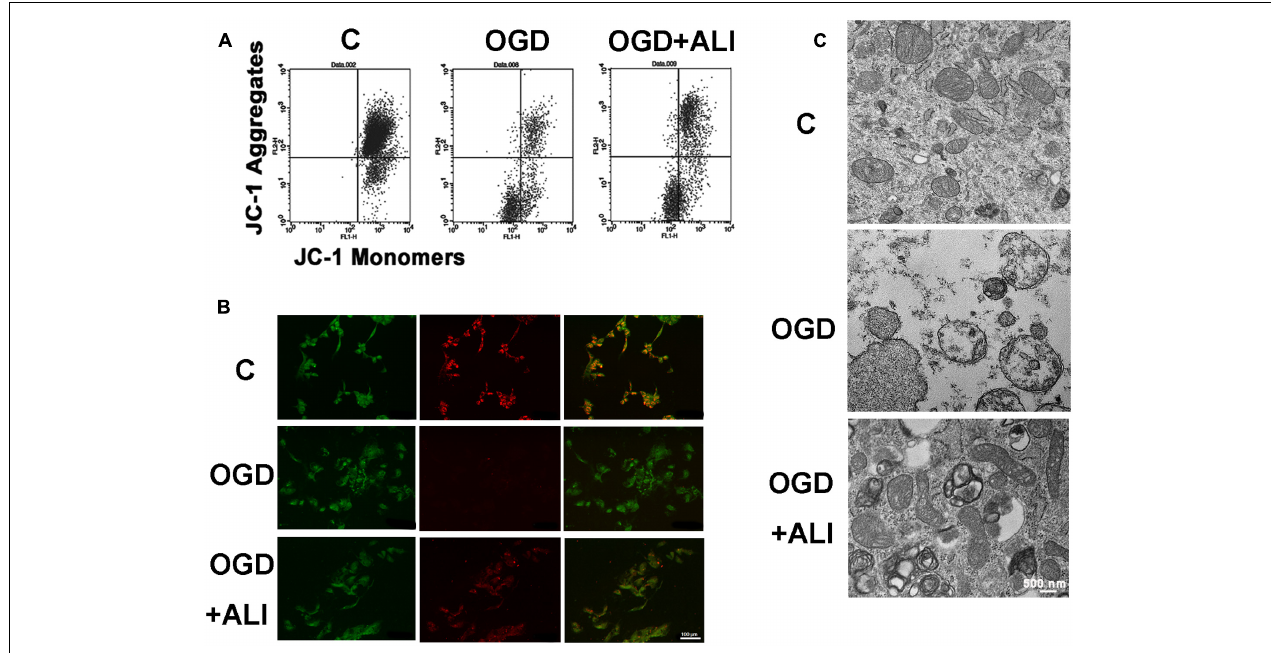
FIGURE 5 | Aliskiren attenuates OGD-induced the reduction of mitochondrial transmembrane potential (MTP) and recovers mitochondrial intact in H9c2 cells. (A) Flow cytometric analysis of MTP by JC-1 staining. (B) Confocal microscopy of JC-1 staining from H9c2 cells with or without aliskiren under OGD for 16 h. Bar: 100 µ m. (C) The effect of aliskiren on the ultrastructure of intact mitochondrial in OGD-treated H9c2 cells was examined by transmission electron microscopy. Bar: 500 nm. Each of the experiments was repeated three